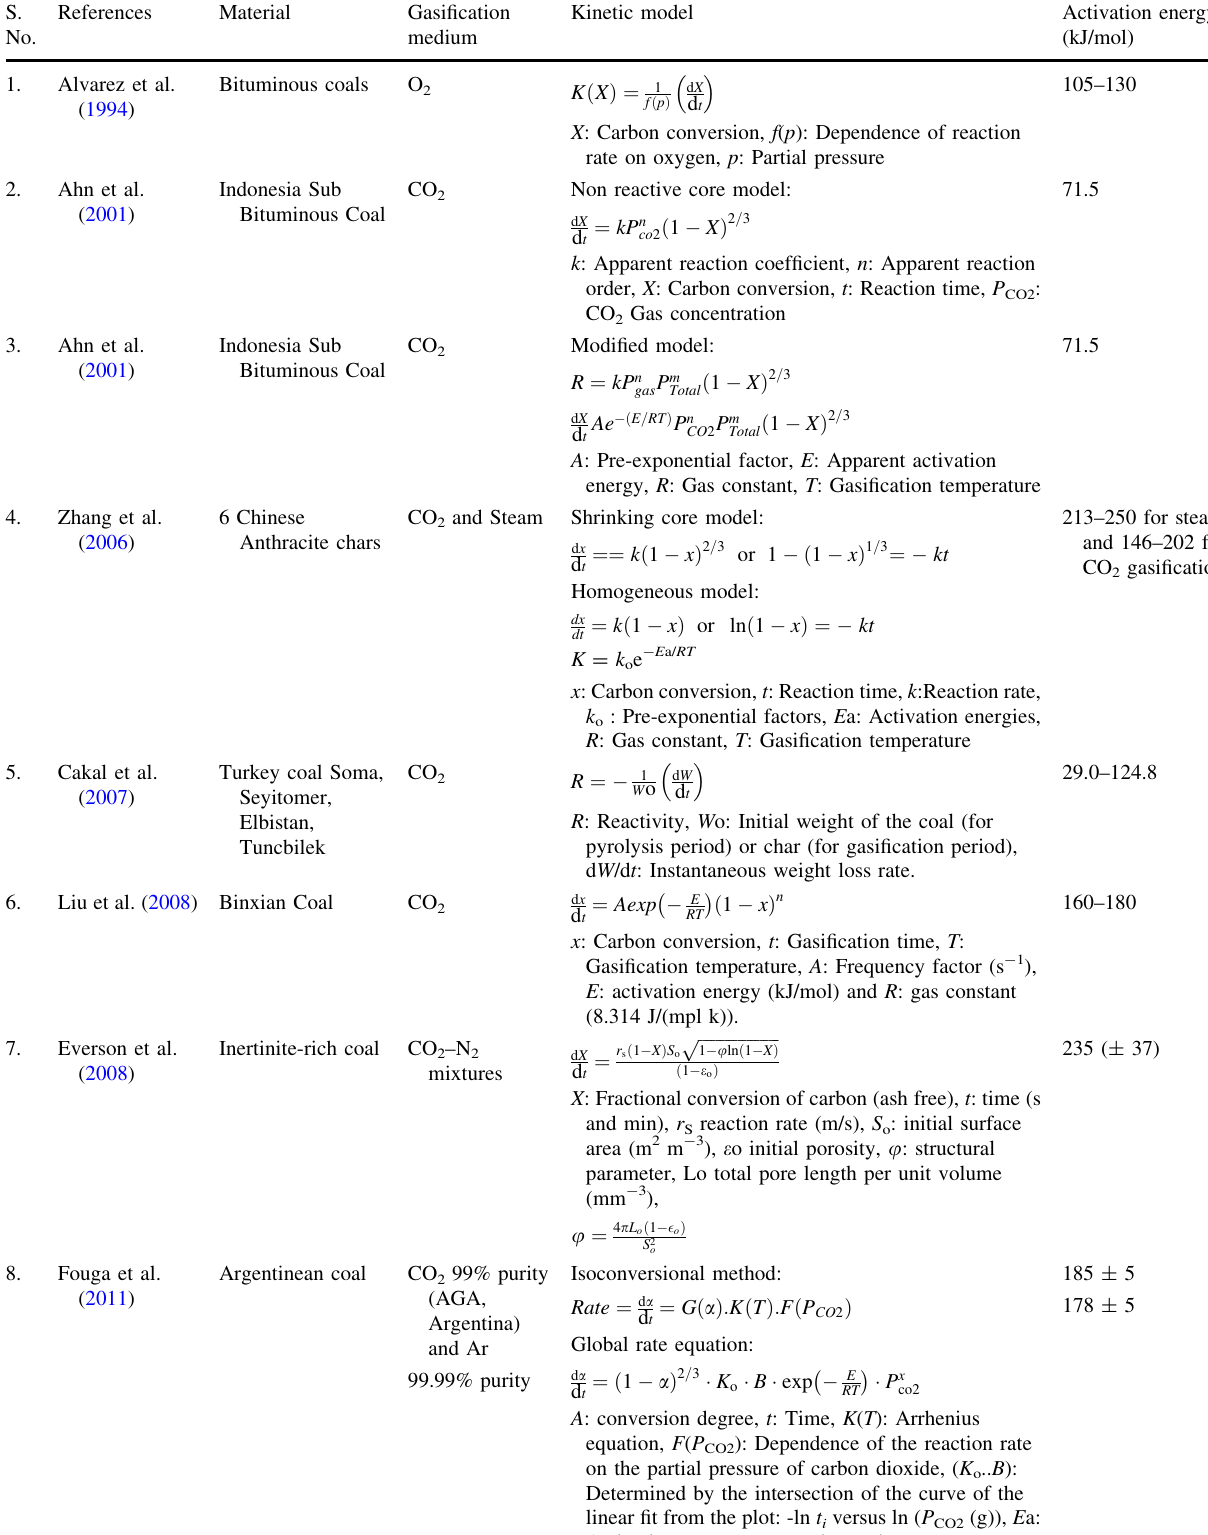
Table 1 Kinetic models and activation